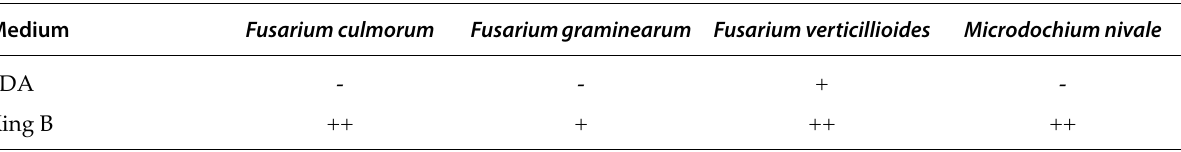
Table 3 . In vitro effects of Paenibacillus polymyxa SGK2 on the four fungal pathogens on two growth media. Petri dishes were incubated at 28°C for 7 d, and presence and sizes of inhibition zones were